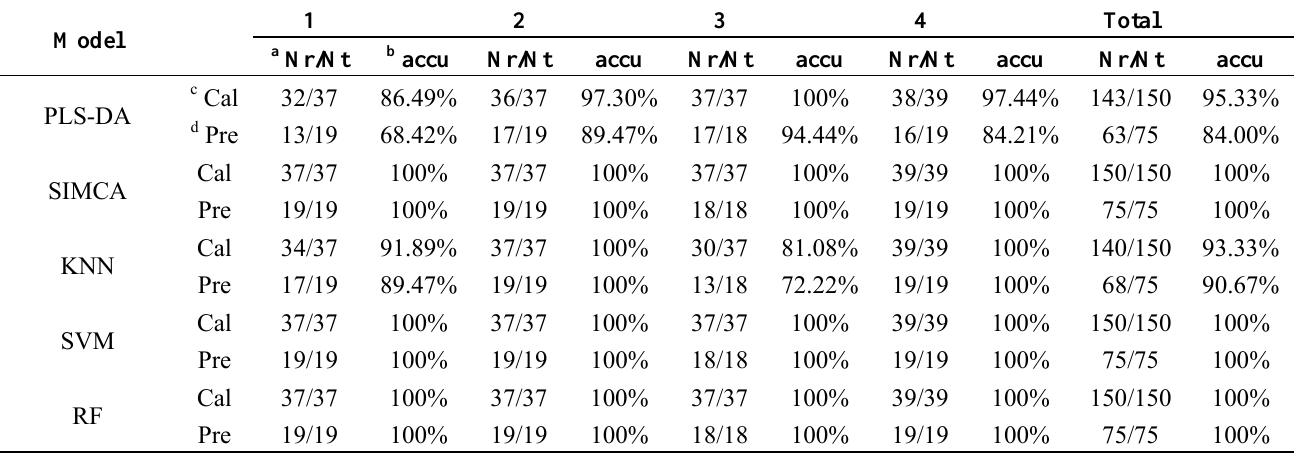
Table 1. Results of classification models based on full